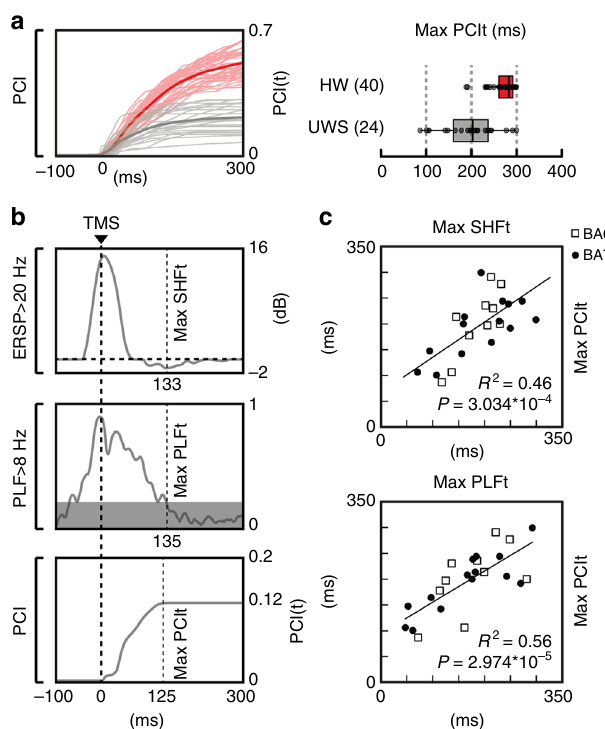
Fig. 4 The occurrence of an OFF-period prevents the build-up of PCI. a For each TMS/EEG measurement, the temporal evolution of PCI, i.e. PCI(t), calculated in HW (thin red lines) and UWS patients (thin gray lines) are shown together with their grand average (thick lines). The boxplot shows the time at which PCI reaches its maximum value (max PCIt) for HW and UWS patients. The boxplot displays the median (center line), the fi rst and third quartiles (bounds of box). The whiskers extend from the bound of the box to the largest/smallest value no further than 1.5* inter-quartile range. Outlier datapoints are indicated by dots outside whiskers. b The time course of the high-frequency power averaged above 20 Hz (top) and the signi fi cant PLF above 8 Hz (middle) of the electrode with the largest response, together with the temporal evolution of PCI (bottom) are shown for one representative patient (patient 12 in Supplementary Table 2). Thin dashed vertical lines mark the timing of the maximum high-frequency suppression (max SHFt, top), the timing of the last signi fi cant time point of phase-locking (max PLFt, middle) and the time at which PCI reach its maximum value (max PCIt, bottom), respectively. Thick dashed vertical line indicates the occurrence of TMS. c The correlation between max SHFt and max PCIt (top) and the correlation between max PLFt and max PCIt (bottom) are shown. The coef fi cient of determination R 2 and the signi fi cance P level are reported. White squares and black dots represent values corresponding to BA6 and BA7 stimulation,